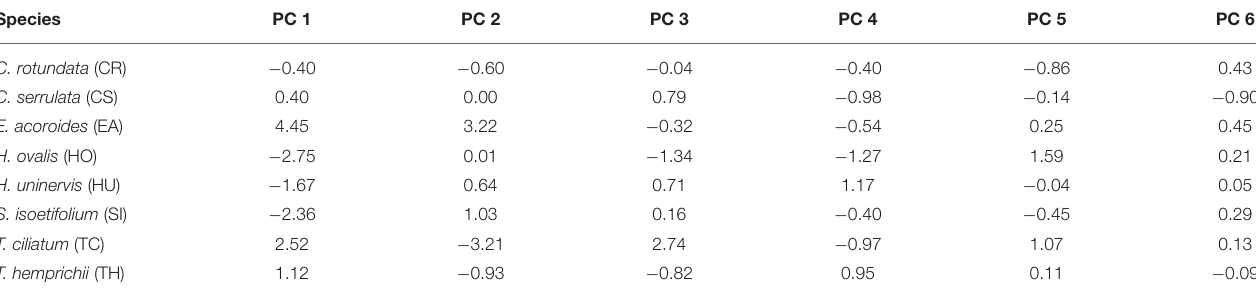
TABLE 4 | Centroids of the species hypervolumes in the six dimensions of the multidimensional space created by the ordination of the functional traits ( Figure 6 ). Species